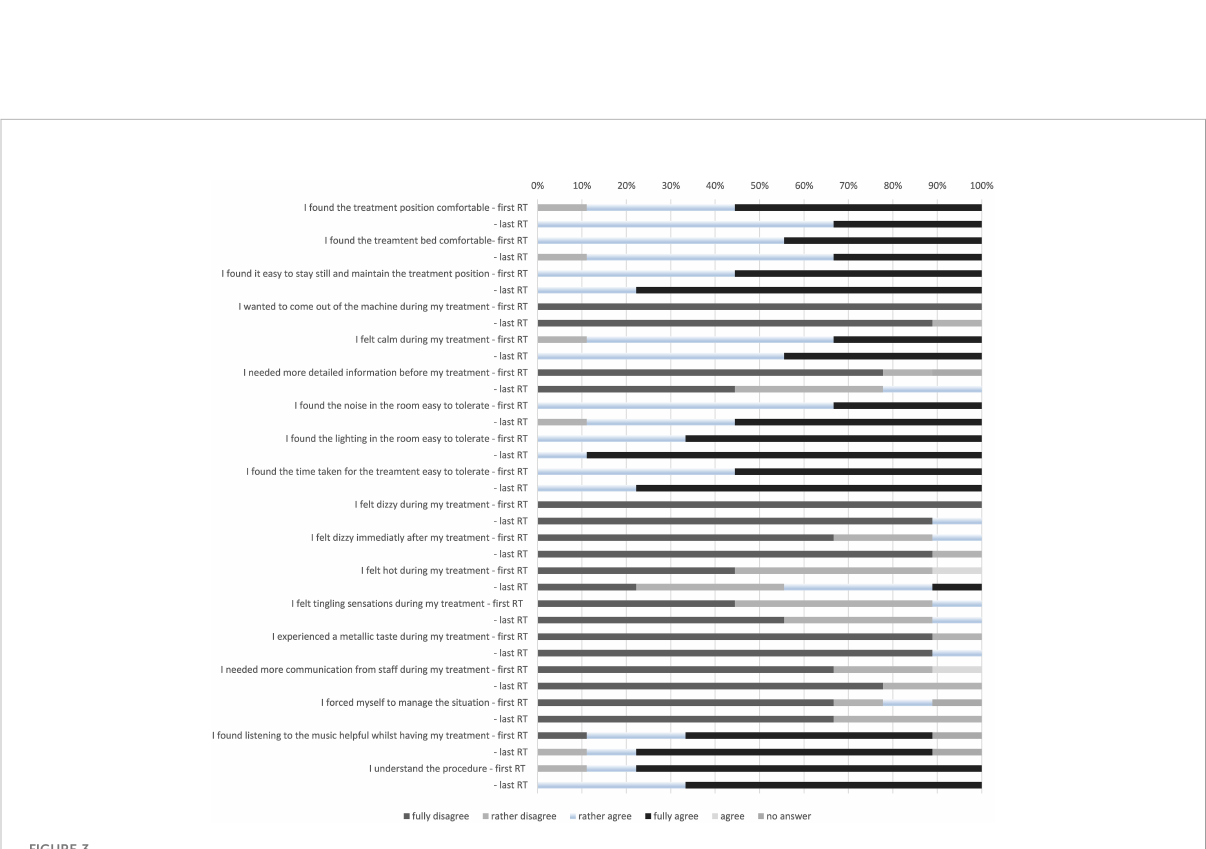
FIGURE 3 Patient acceptance of various aspects of online MRgSBRT. RT